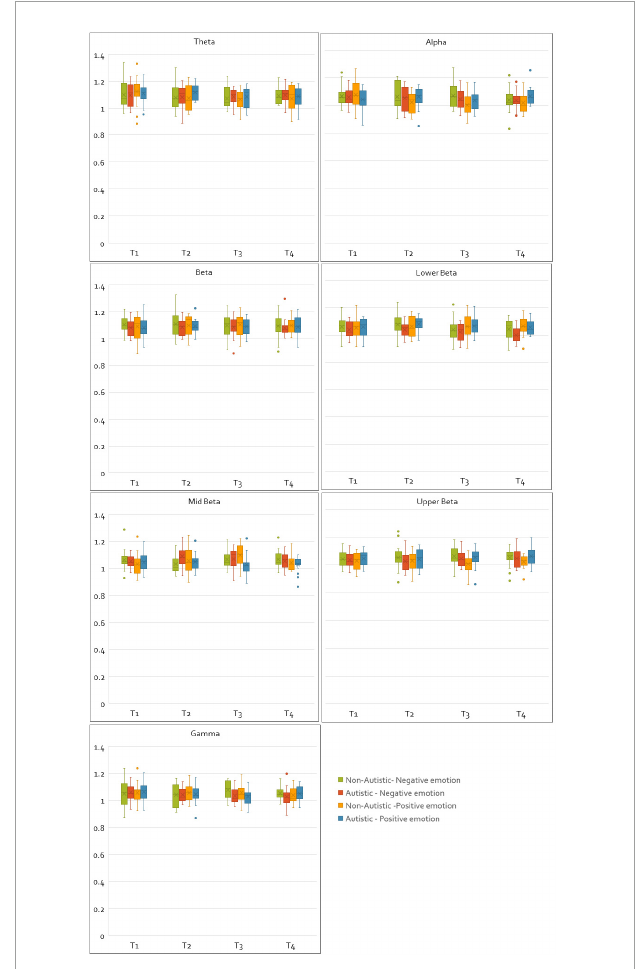
FIGURE3 Plots of normalized and integrated CC values for the autistic and non-autistic groups. The figure shows the normalized and integrated CC values plotted for all frequency bands, time windows and emotions (negative and positive) as box plots for the autistic and non-autistic